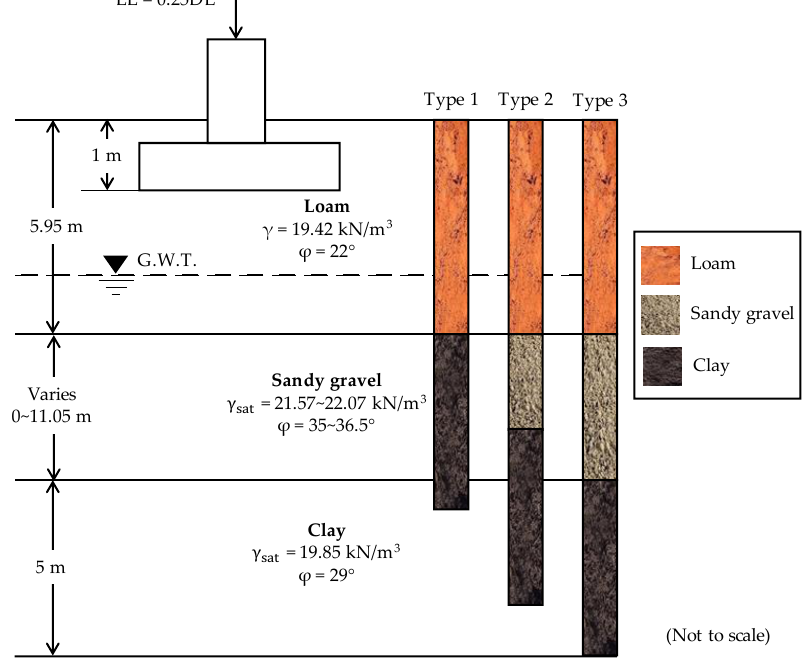
Figure 3. Design problem and types of soil profiles in Nur-Sultan city. Table 3. Soil engineering properties in Nur-Sultan